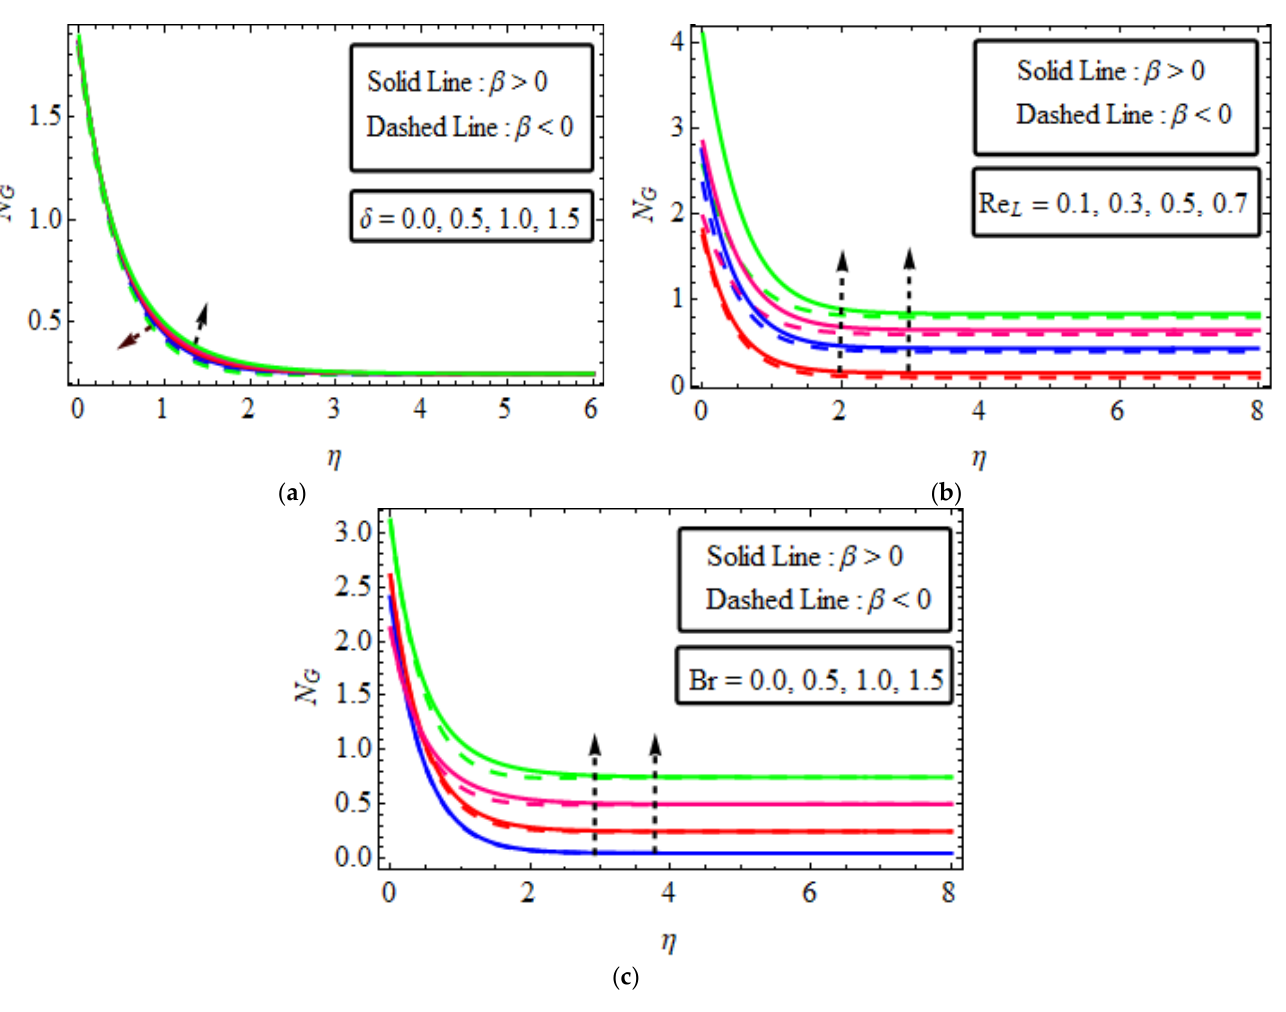
Figure 7. ( a – c ) The impact of